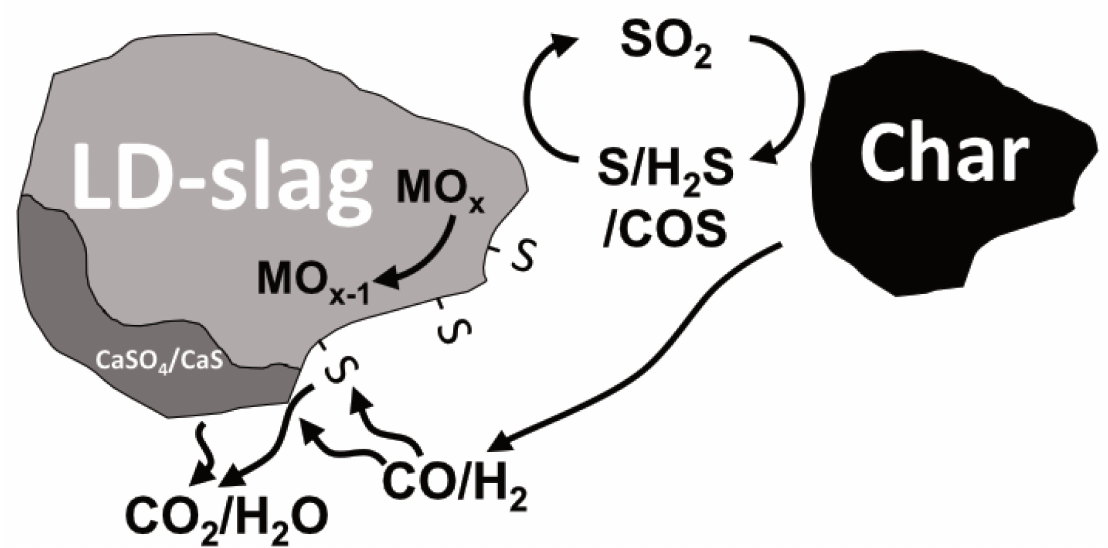
Figure 17. A graphical summary of reaction paths involving sulfur suggested in the discussion